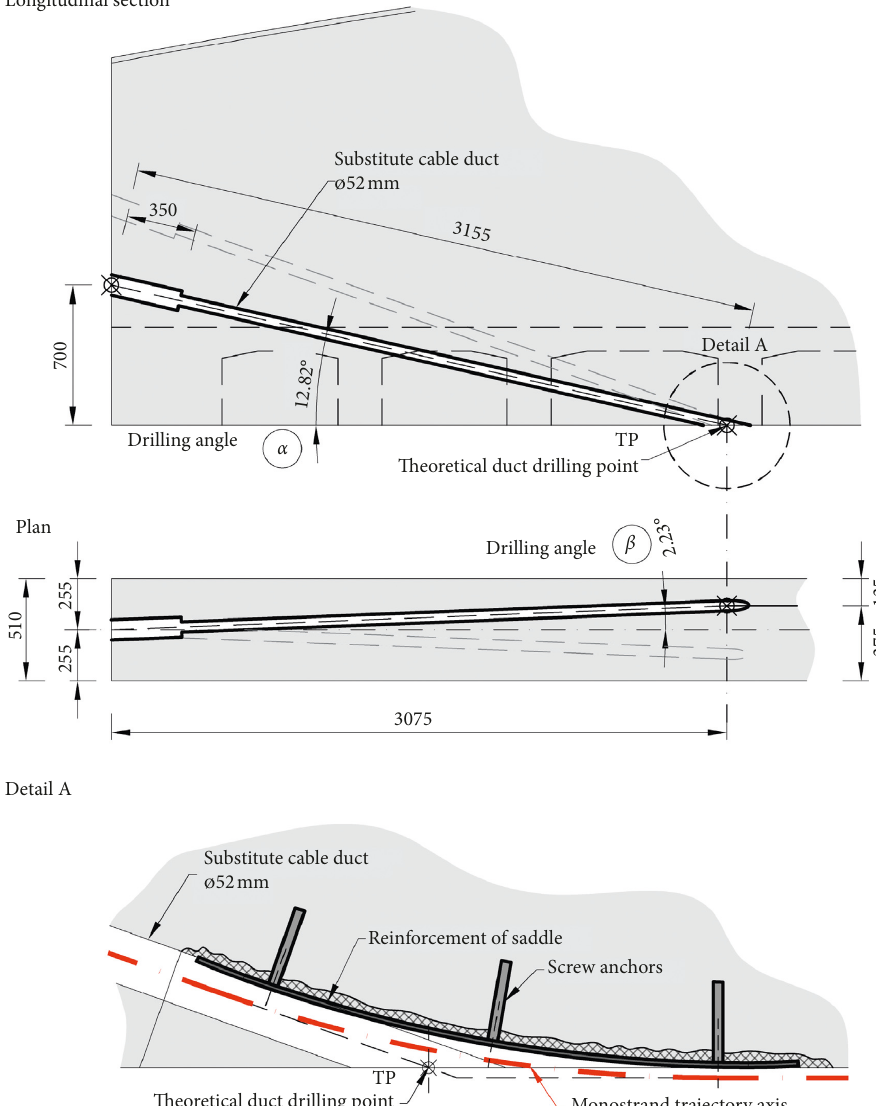
Figure 15: An example drilling scheme for drilling substitute cable ducts. It describes both the vertical ( α ) and horizontal ( β ) angles for drilling ducts. The details of the saddle are also